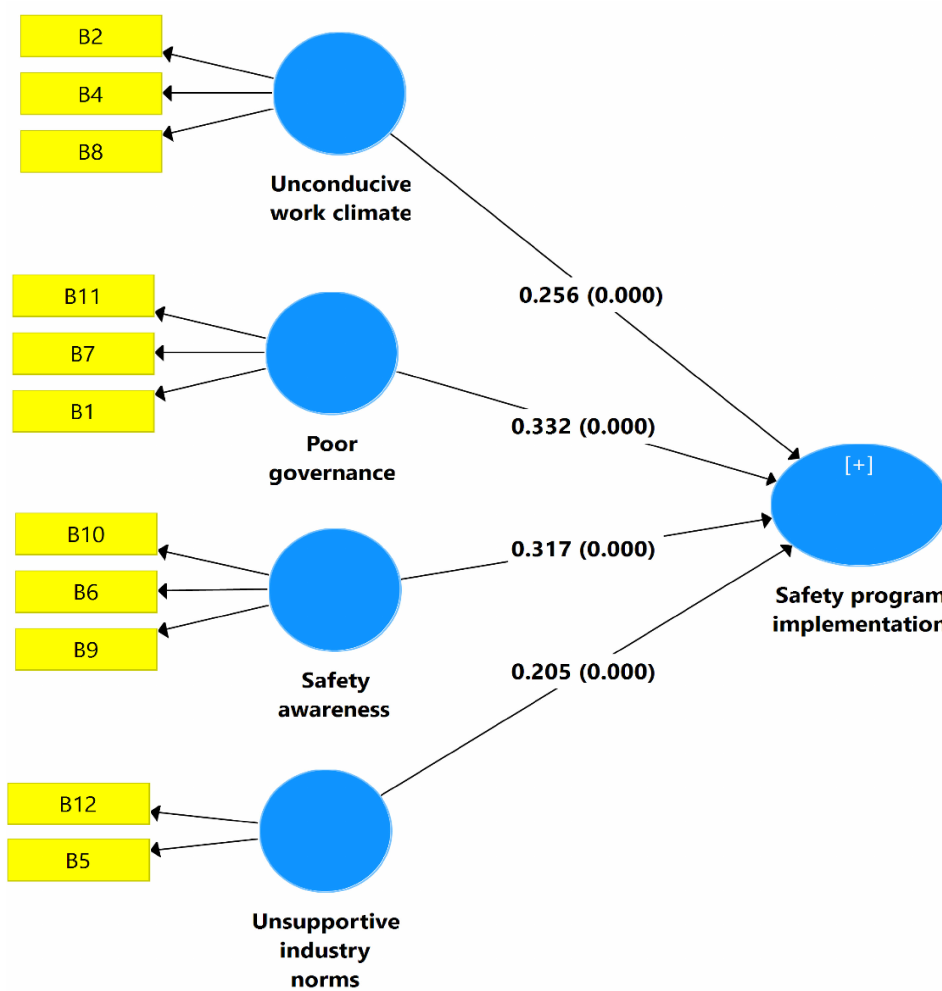
Figure 4. Performing bootstrapping